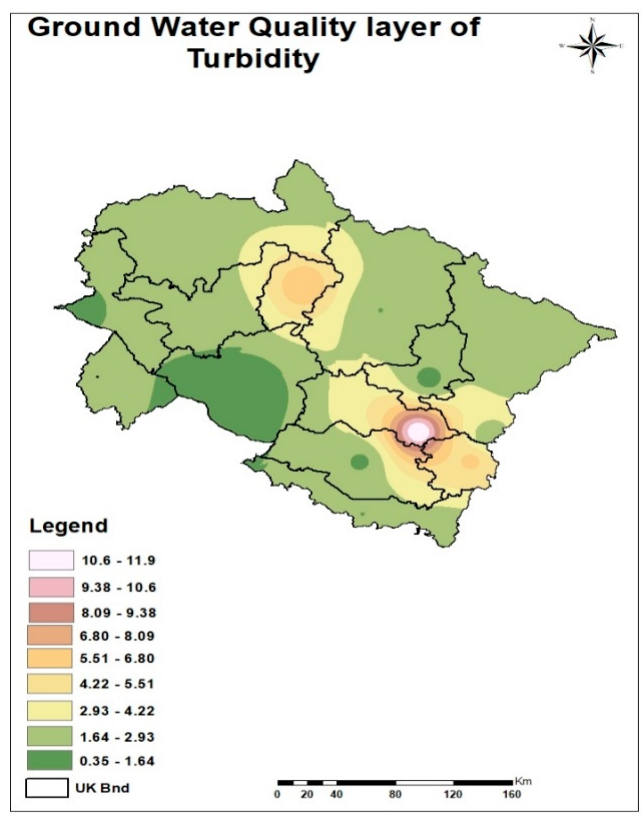
Figure 5. Geospatial maps of the GWQ parameters under different geographical and geological stress conditions.